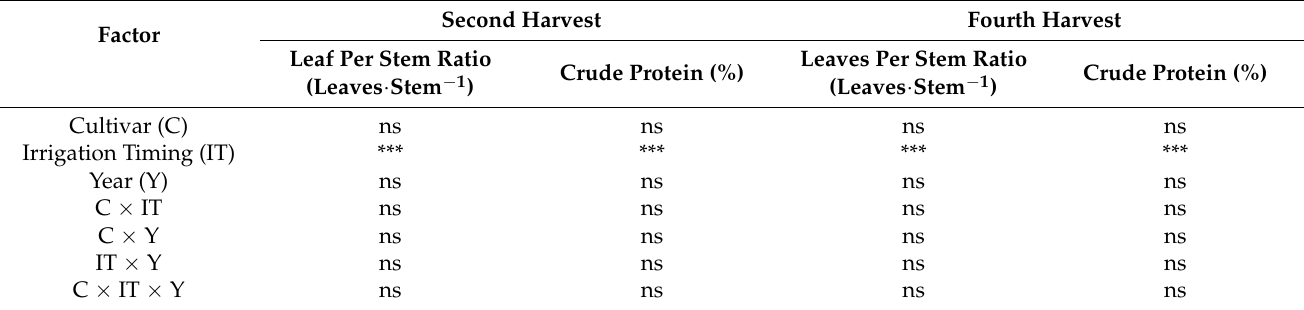
Table 9. The effects of the experimental factors on the leaves per stem ratio (leaves · stem − 1 ) and crude protein (%) values recorded, in the second and the fourth harvest, across the two experimental years. The p -values were derived from an analysis of